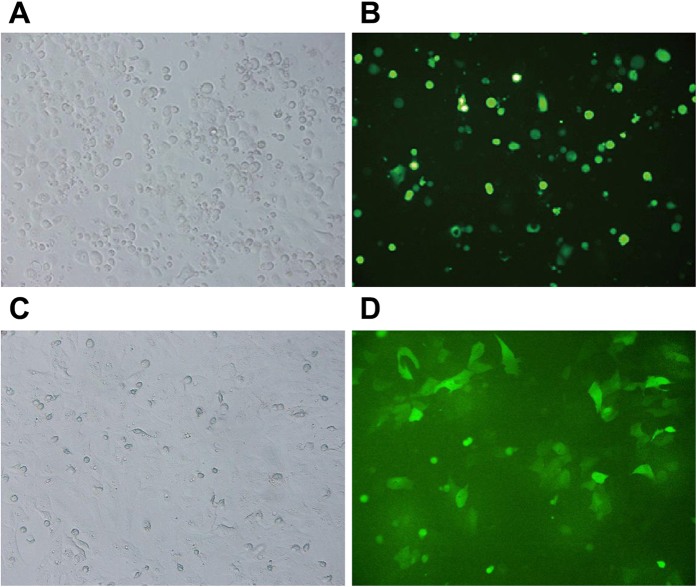
The transfection efficiency of microRNA-122 (miR-122) observation in cholangiocarcinoma under fluorescence microscope.(A) QBC939 cells before transfection under fluorescence microscope; (B) QBC939 cells after transfection under fluorescence microscope; (C) RBE cells before transfection under fluorescence microscope; (D) RBE cells after transfection under fluorescence microscope.